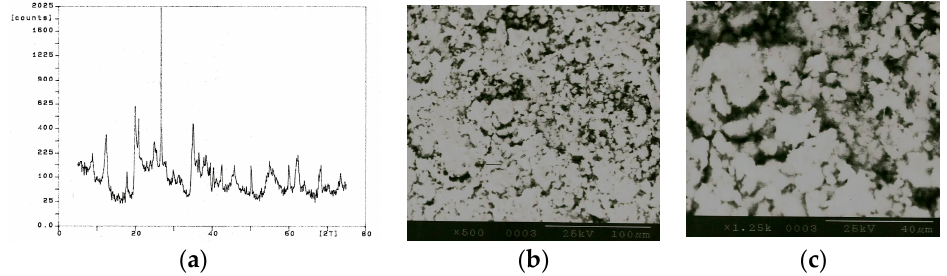
Figure 3. Ball clay (BC) material sample: ( a ) X-ray diffraction pattern for 2 θ angles showing arbitrary counts (counts) versus 2 θ angles (2T) in degrees; ( b ) Scanning electron micrograph at 500× magnification; and ( c ) Scanning electron micrograph at 1250× magnification.